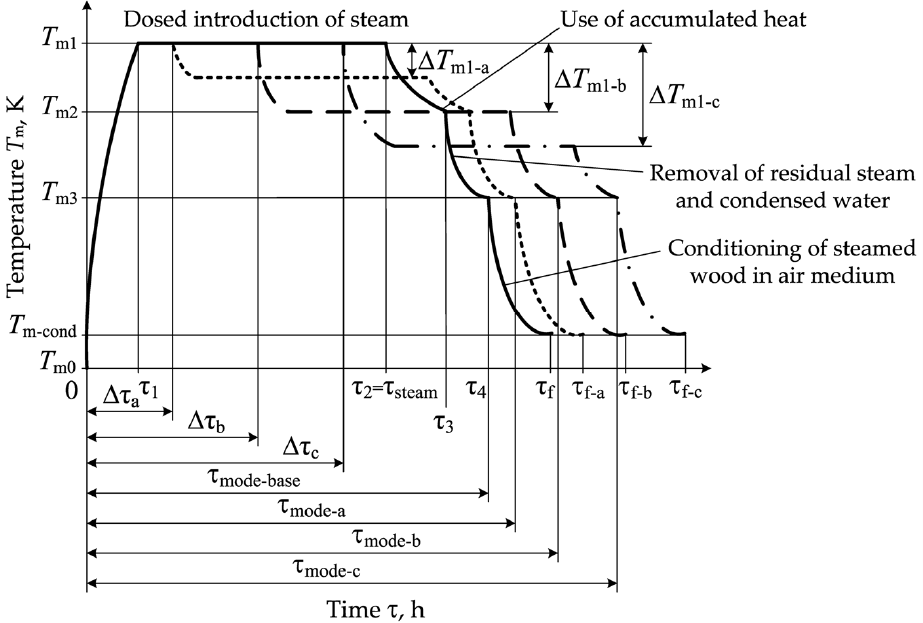
Figure 2. Change of T m during steaming modes in absence and presence of dispatcher intervention. T m1-a = 10 K = 10 ◦ C, ∆ T m1-b = 20 K = 20 ◦ C, and ∆ T m1-c = 30 K = 30 ◦ C; T m2 = 383.15 K (i.e., t m2 = 110 ◦ C); T m3 = 353.15 K (i.e., t m3 = 80 ◦ C); T m-cond = 293.15 K (i.e., t m-cond = 20 ◦ C);